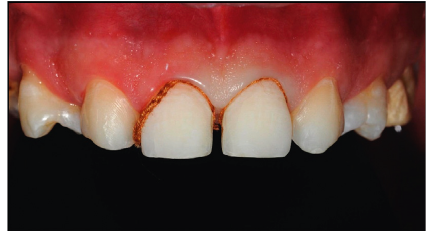
Figure 14: Gingival clearance prior to cementation.